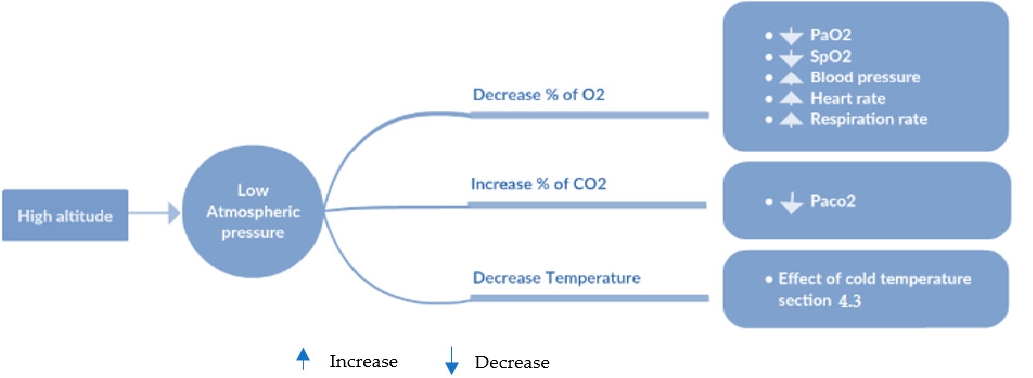
Figure 6. The effect of atmospheric pressure.